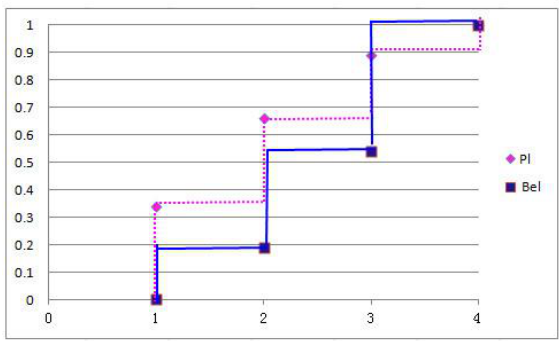
Figure 7.Cumulative belief and plausibility values of urban flood risk measured by a random set ( E = { P 